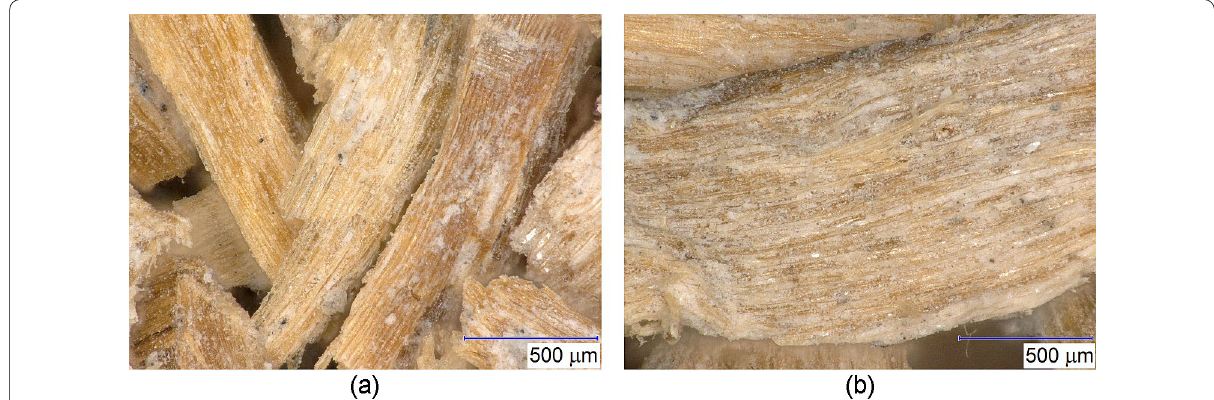
Fig. 5 Structure of separated chips from crushed cuttings from production of cement-bonded particleboards (images from optical microscope): a 0.5 to 1.0 mm (magnification 70x) b 1.0 to 2.0 mm (magnification